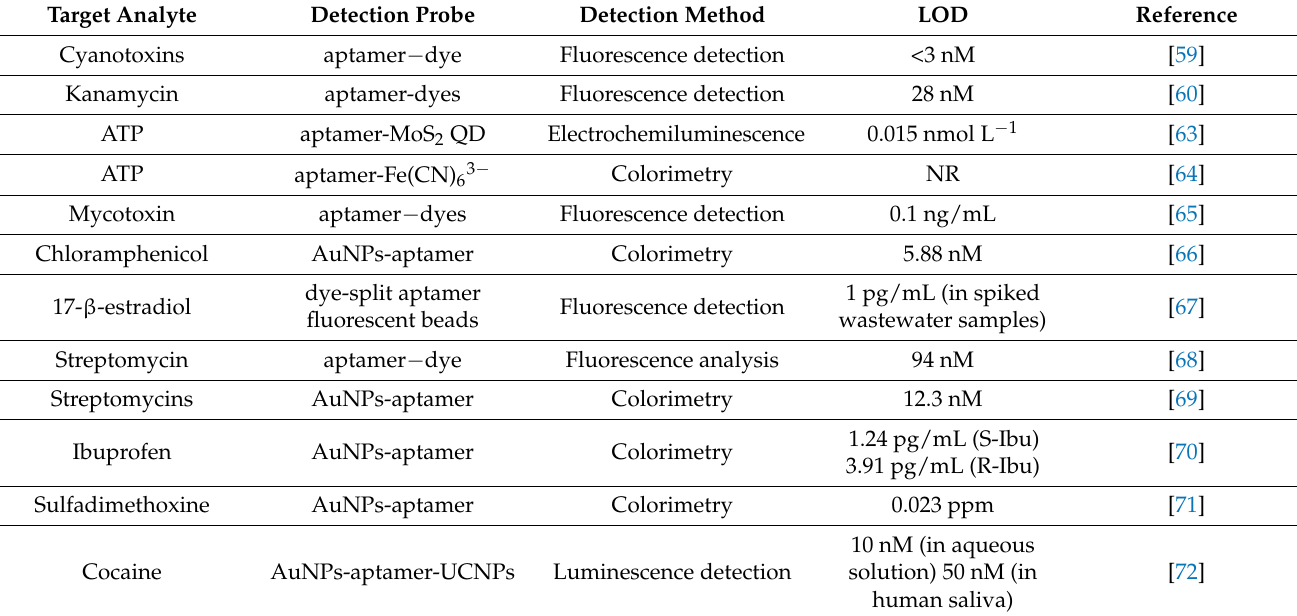
Table 1. A summary of small-molecule detection using smartphone-based